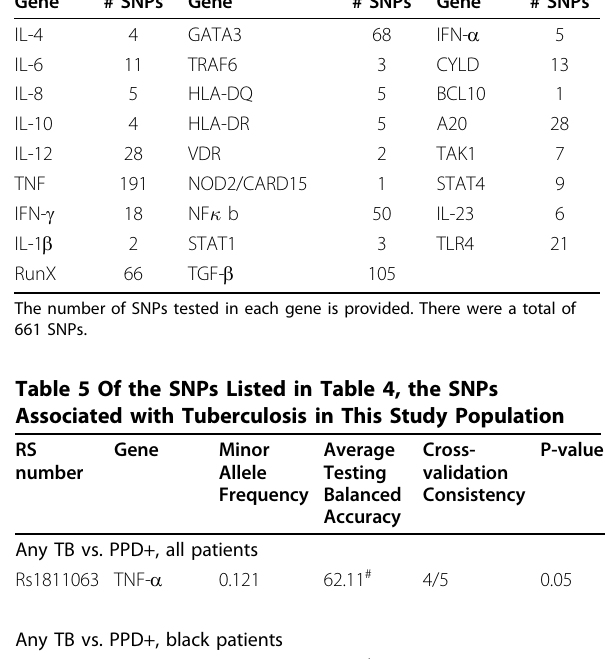
These results point to the importance of IL-1 b +3953, VDR Fok 1 A/G, and the TLR2 microsatellite in extra-